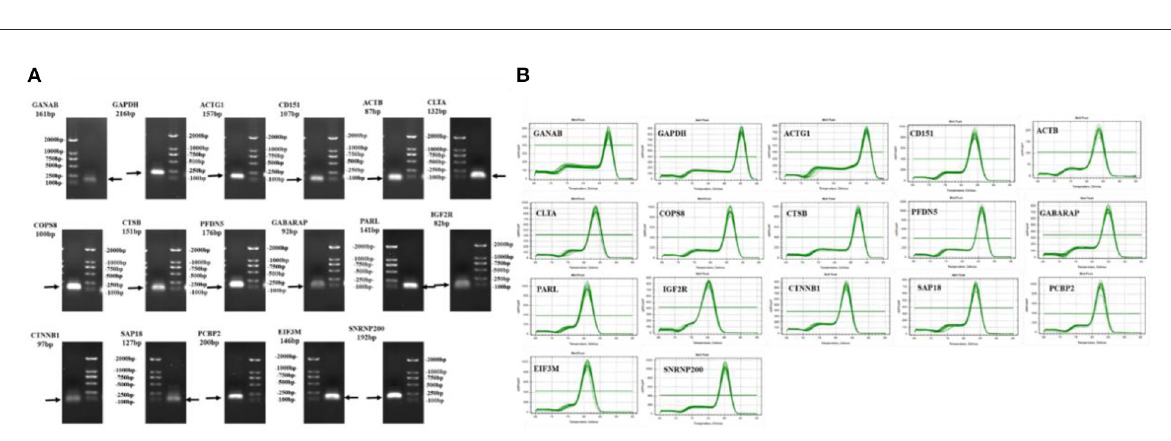
FIGURE2 Detection the primer-specific detection of candidate reference genes. (A) Agarose gel electrophoresis detection of primers; (B) Melting curves of primers.